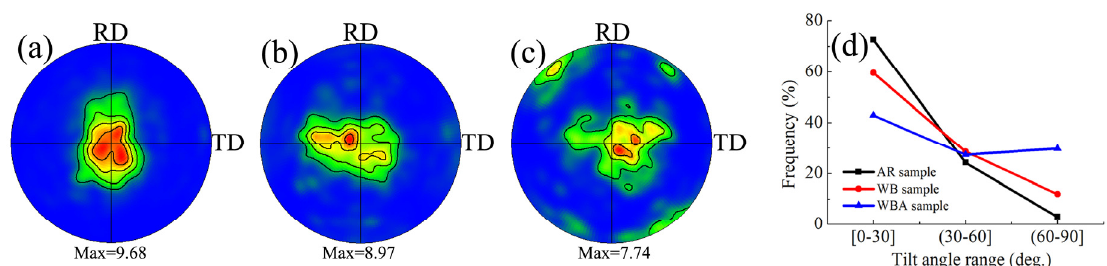
Figure 4. The {0001} pole figures of ( a ) AR sample, ( b ) WB sample and ( c ) WBA sample. ( d ) Texture component figure in various samples. Tilt angle is the misorientation of the c -axis of grains with respect to the normal direction (ND). The contour levels in pole figures are 2, 4, 6 ….